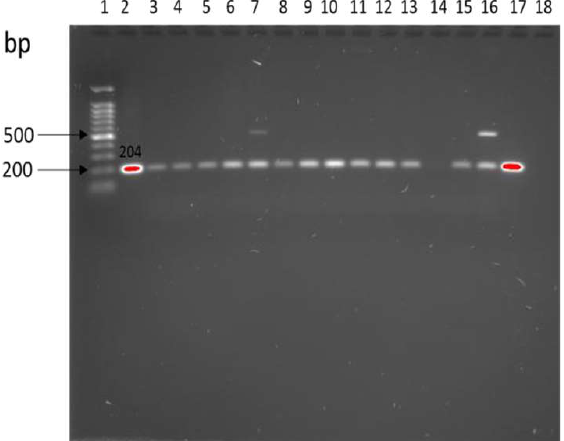
Figure 2. Amplification of the ompC gene in Salmonella spp. Lane 1: 1 kb ladder, lane 2: positive control Salmonella typhimurium ATTC 13311, lane 3–17: samples, lane 18: E. coli ATTC 25922 negative controls. The hly and prs genes for L. monocytogenes and Listeria spp, respectively, were amplified as demonstrated in Figure 3. Overall, about 23.2% (66/285) of environmental samples (water, manure, water) from cattle and goat farms were positive for both L. monocytogenes and Listeria spp. (Table 3). The highest occurrence of L. monocytogenes at 3.9% (11/285) was observed in soil (CF1) and manure CF2 and was not significantly different ( p < 0.05) from soil at 3.2 (9/285) in goat farm. L. monocytogenes was detected at 0.4% (1/285) in both trough water and runoff